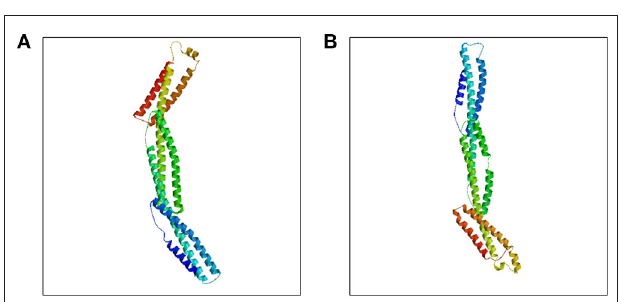
FIGURE 3 | Prediction of SPTB protein structure by Swiss-model. (A) Wild type SPTB, (B) Mutant